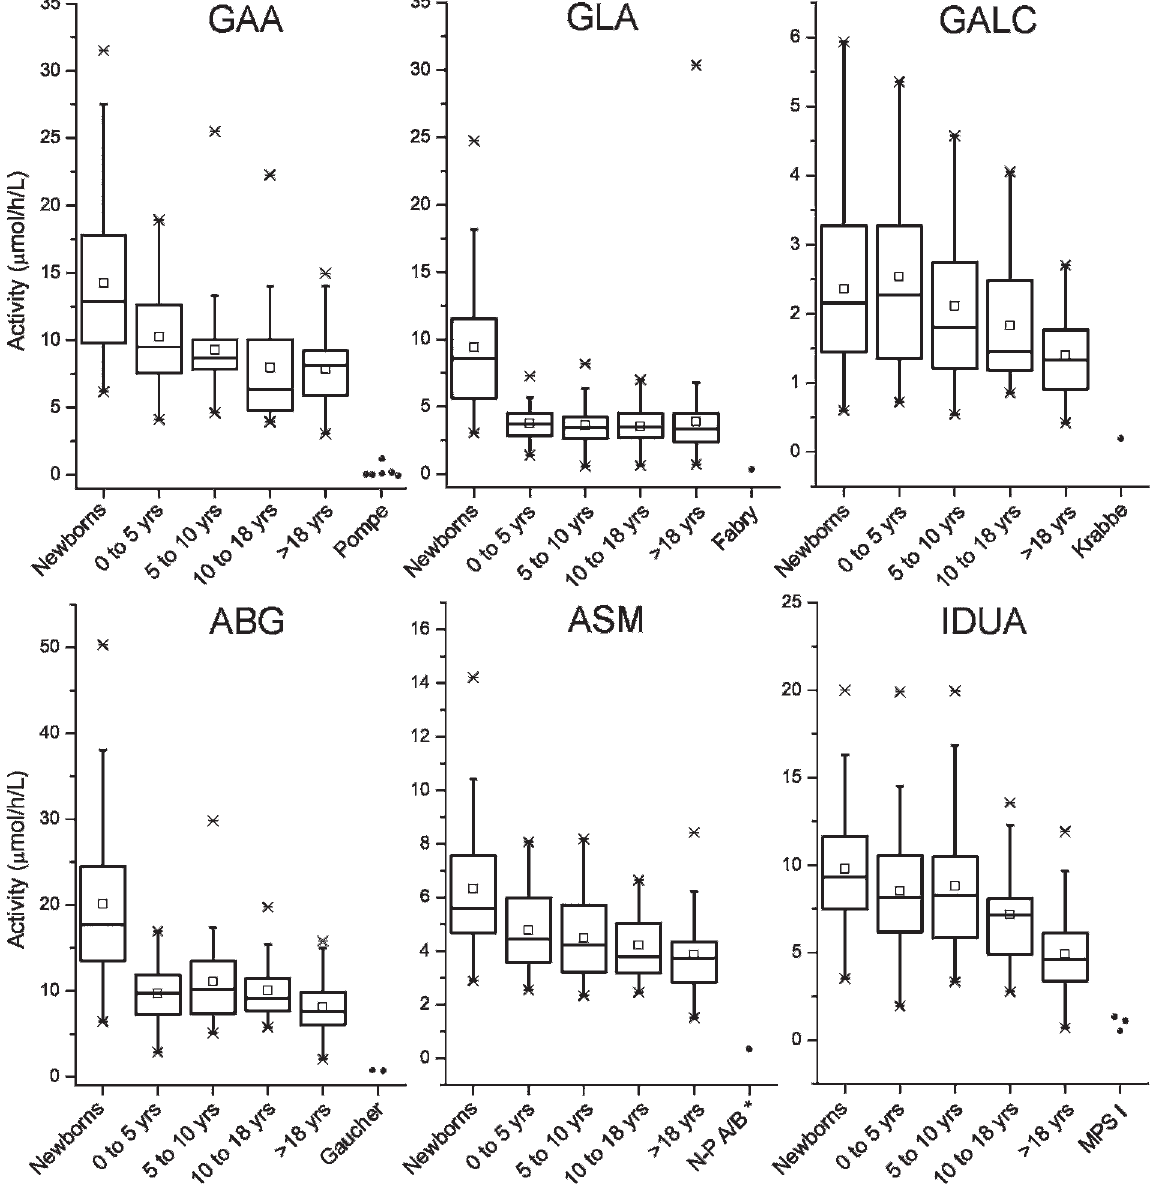
Figure 1 - Comparison of the enzyme activities ( m mol/h/L) between DBS samples from newborns and non-affected adults grouped according to age and DBS samples from patients with LSDs. *No patients with Niemann-Pick A/B disease were available. This sample corresponds to a DBS from a healthy patient subjected to protein denaturing conditions (heat